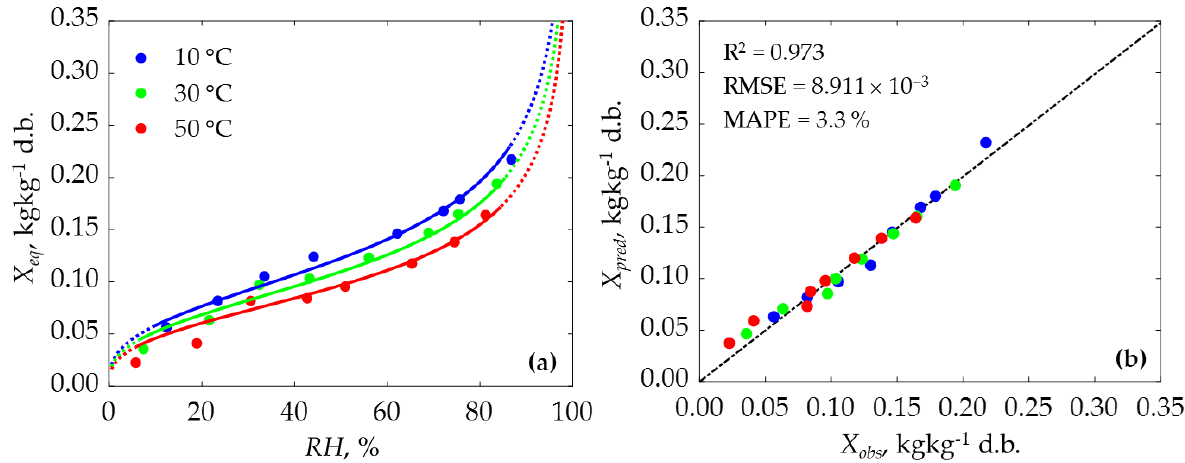
Figure 2. ( a ) Sorption isotherm for wheat cv. ‘Pionier’ at 10, 30, and 50 °C. Dashed lines reflect extrapolations beyond the dataset used for fitting; ( b ) scatter plot of predicted X pred versus observed moisture content X obs .